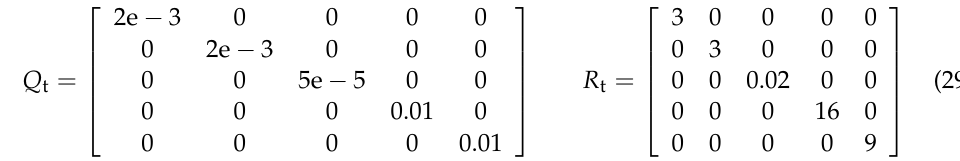
Figure 8. Experimental environment deployment